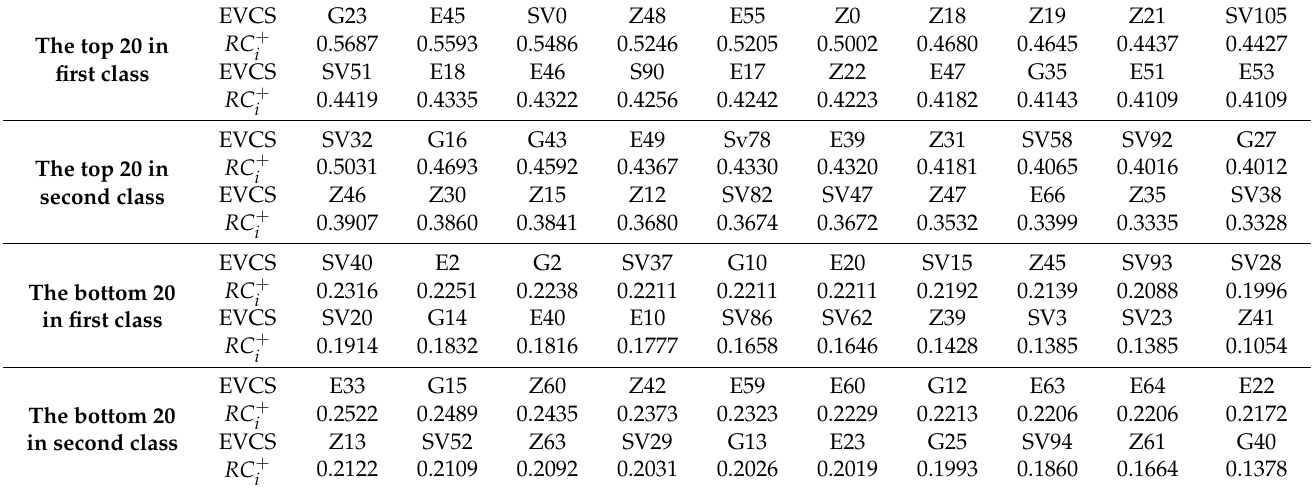
Table 5. Ranking of 20 best and worst current EVCSs in first and second classes.